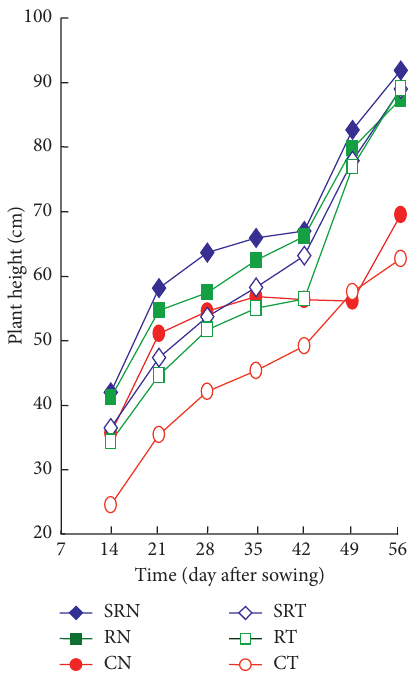
Figure 2: Plant height maize from 14 to 56 DAT ( n � 3).